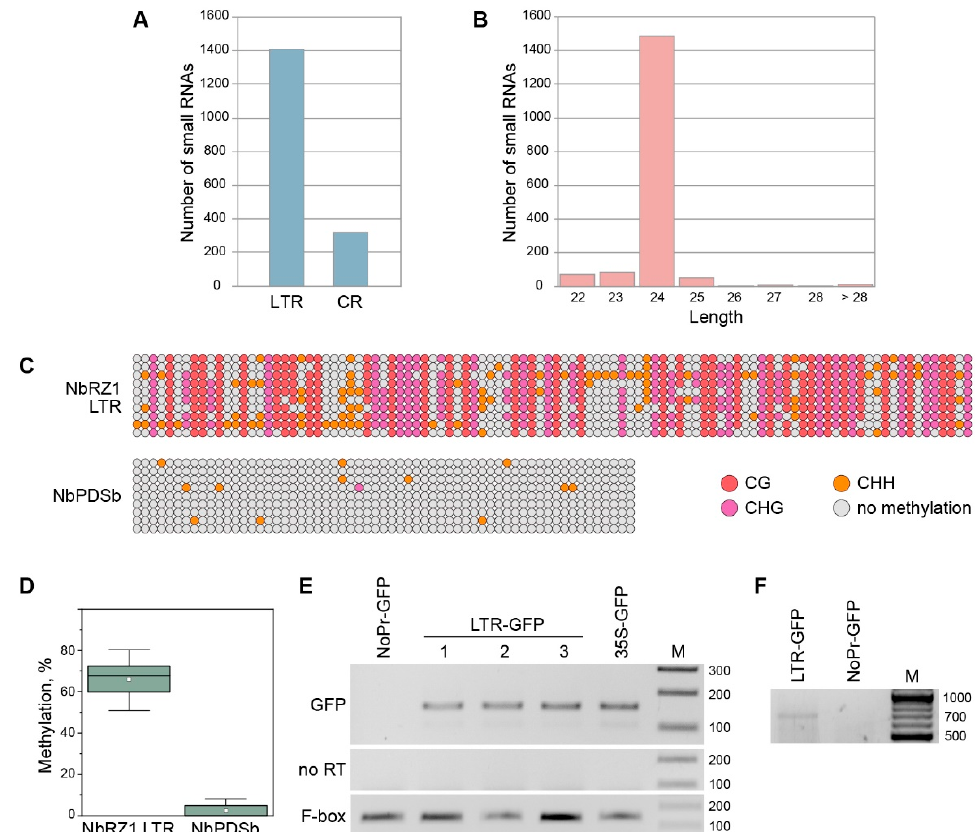
Figure 3. Silencing and transcription of retrozyme genomic loci. ( A ) Distribution of retrozyme-specific small RNAs between the CR and LTR regions. ( B ) Length distribution of retrozyme-specific small RNAs. Length in nucleotides is indicated. ( C ) Bisulfite sequencing analysis of cytosine methylation of the LTR region of the NbRZ1 genomic locus. A region of the NbPDSb promoter was analyzed in parallel as a control. Each row of circles represents one sequenced clone and shows cytosine residues in the analyzed regions as circles. Nonmethylated cytosine residues are shown in gray, and methylated cytosine residues are shown in color, as indicated. ( D ) Percentage of methylated cytosine residues in the NbRZ1 LTR region. The box represents the interquartile range (IQR), the horizontal line represents the median, white squares show the mean, and whiskers show the range within 1.5 IQR. ( E ) Analysis of the ability of the NbRZ1 LTR region to direct transcription. Total RNA from N. benthamiana leaves agroinfiltrated for the expression of constructs indicated above the gel was analyzed by RT–PCR. No RT—amplification carried out without reverse transcription. Primer specificity is indicated on the left. F-box primers were used as a control. ( F ) 5 (cid:48) -RACE analysis of RNA isolated from N. benthamiana leaves infiltrated with agrobacteria carrying either the LTR-GFP construct or the NoPr-GFP construct. M—DNA size